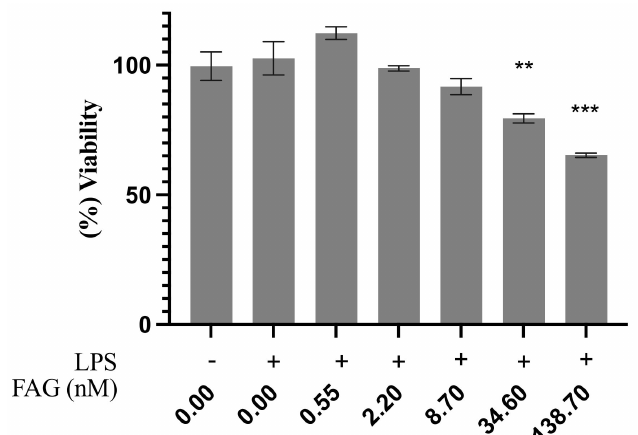
Figure 2. Cytotoxic evaluation of the new FAG on RAW264.7 cells. FAG was added two hours before induction with LPS. Percentage of viability was expressed relative to that of LPS-untreated RAW 264.7 cells. Bars represent mean ± SD ( n = 3), **; p < 0.01, ***; p < 0.001, compared to untreated LPS-stimulated RAW 264.7 cells.